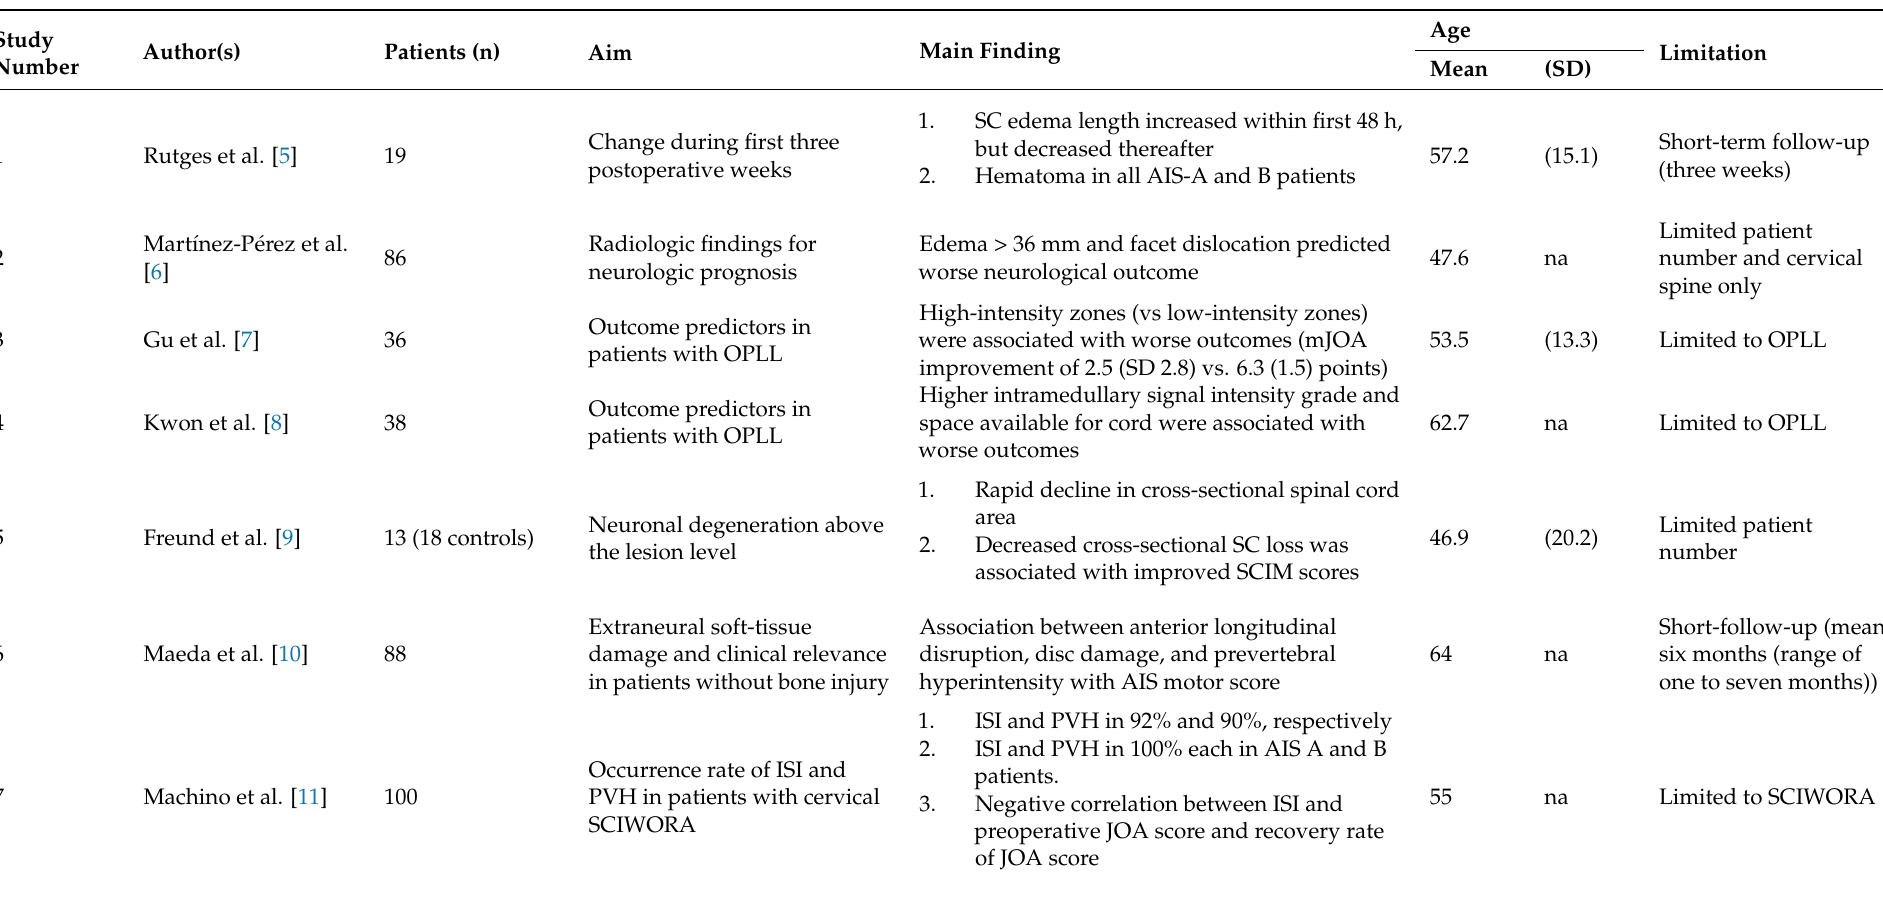
Table 5. Previous literature on prospective studies about acute spinal cord injury, magnetic resonance imaging, and adverse events ( n = 41)